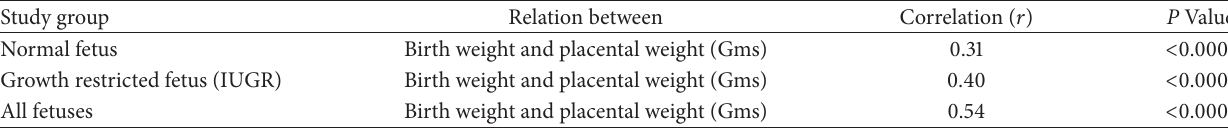
Table 7: The correlation between birth weight and placental weight in the study